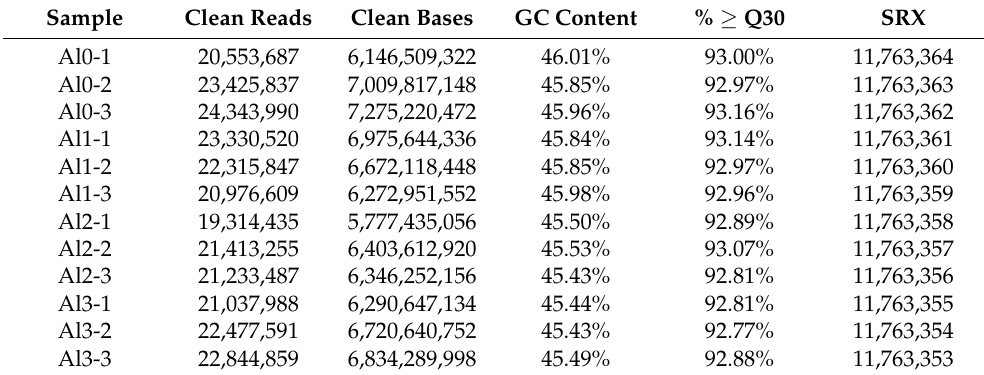
Table 2. Sequencing statistics.